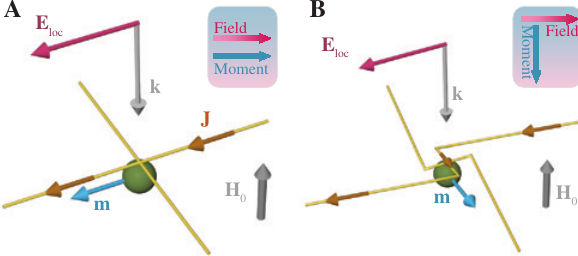
Figure 4: Topologies of nonreciprocal bianisotropic inclusions. (A) Uniaxial Tellegen inclusion. (B) Uniaxial artificial moving inclu- sion. The ferrite sphere is shown in green. The inclusions are